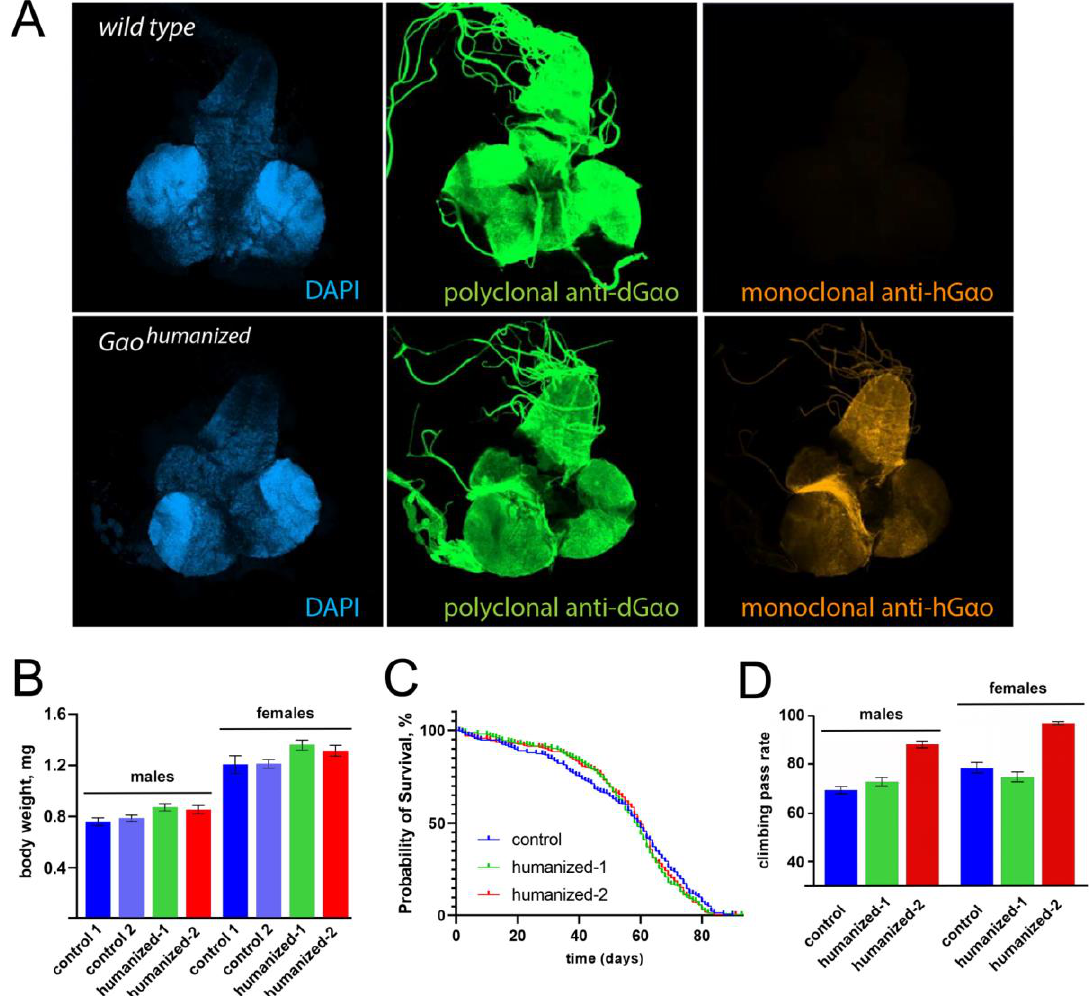
Figure 3. ( A ) Expression of humanized and wild-type G α o in brains and ventral nerve cords of 3rd instar larvae. The upper panel represents a sample from wild-type larvae and the bottom panel—from dGao[humanized] . The immunostaining demonstrates specific recognition of the humanized protein (bottom right) with the monoclonal antibody recognizing hG α o; the polyclonal anti-dG α o antibodies, in contrast, recognize both dG α o and hG α o (the latter with a lower a ffi nity as seen in the middle panels, which were recorded with identical confocal settings). ( B ) The body weight of the humanized flies is normal. The body weight in two control lines (the line used for initial injection is control 1 and an independent line is control 2) and the two homozygous humanized lines generated in our study was determined through measuring the weight of groups of fifty adult (2–3 days after hatching) male or female flies kept under non-crowding conditions; the individual fly body weight was then recalculated. Data are shown as mean ± sd, n = 11 to 13 groups of fifty flies. ( C ) The life span of 250 adult flies (125 males and 125 females; control animals were of the same genotype as ‘control 1’ in ( B )) was determined during 93 days. ( D ) The locomotion behaviour of adult flies was measured in the negative geotaxis assay. Ten groups of 15 flies were measured three times for males, and the same for females, for each genotype. Data are shown as mean ± sem, n = 30. The T-test shows significant di ff erences between the G α o[humanized-2] line and the control line, as well as between the G α o[humanized-2] line and the G α o[humanized-1] line, for both males and females ( p -values < 10 − 8 ), but not between the G α o[humanized-1] and control lines ( p -value >